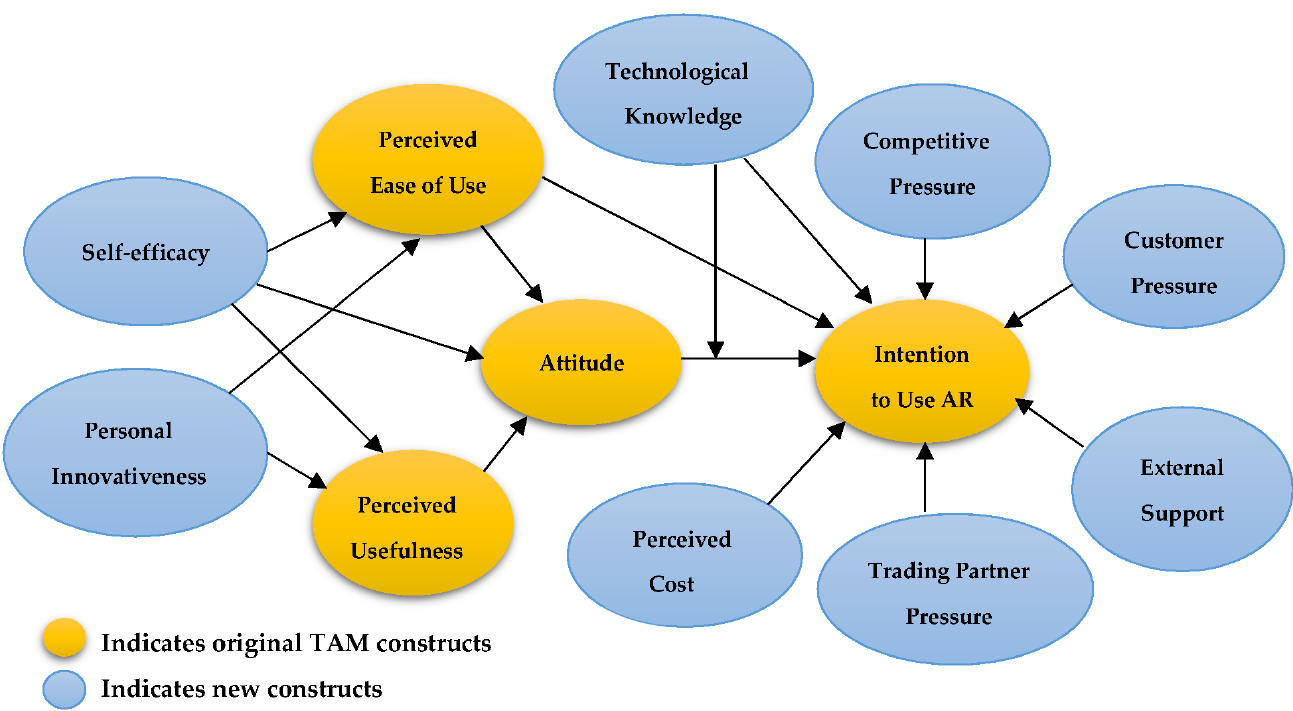
Figure 1. Conceptual model.